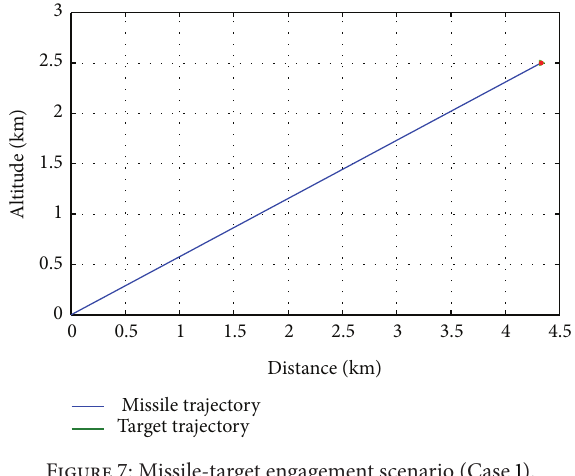
Figure 7: Missile-target engagement scenario (Case 1).